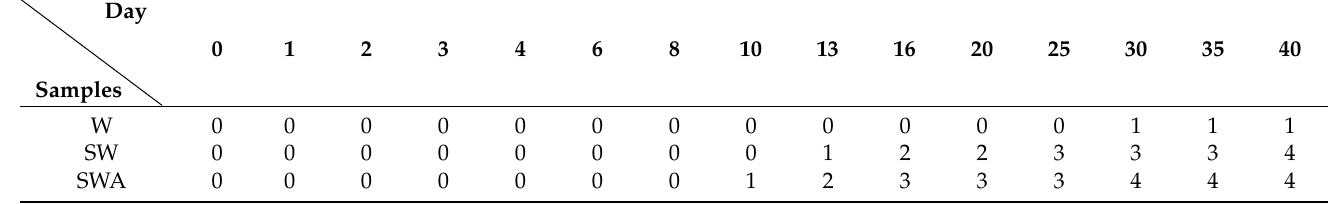
Table 1. The changes of blackness during black